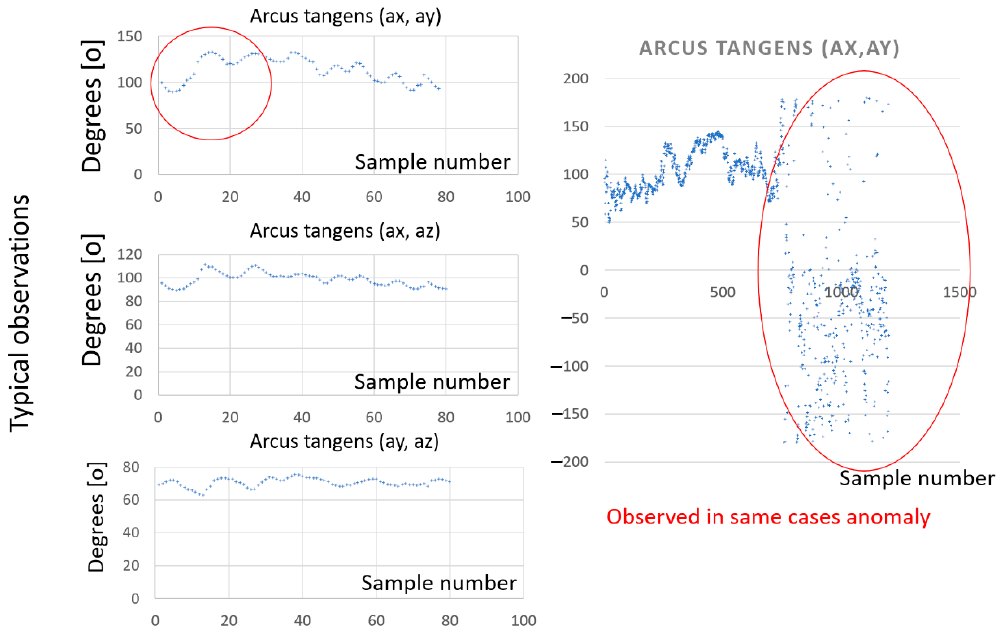
Figure 11. Distribution of inverse tangent function of accelerations: Source: authors’ own materials.